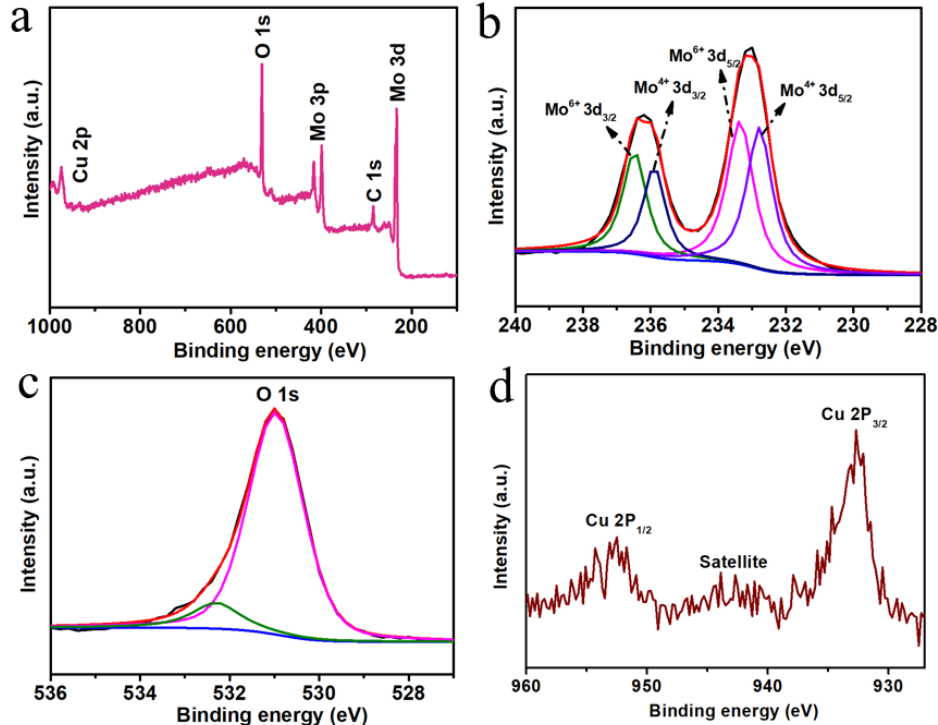
Figure 4. ( a ) XPS survey and high-resolution spectra of ( b ) Mo 3d, ( c ) O 1s and ( d ) Cu 2p of Cu MoO 3 doped MoO 3 nanosheet.